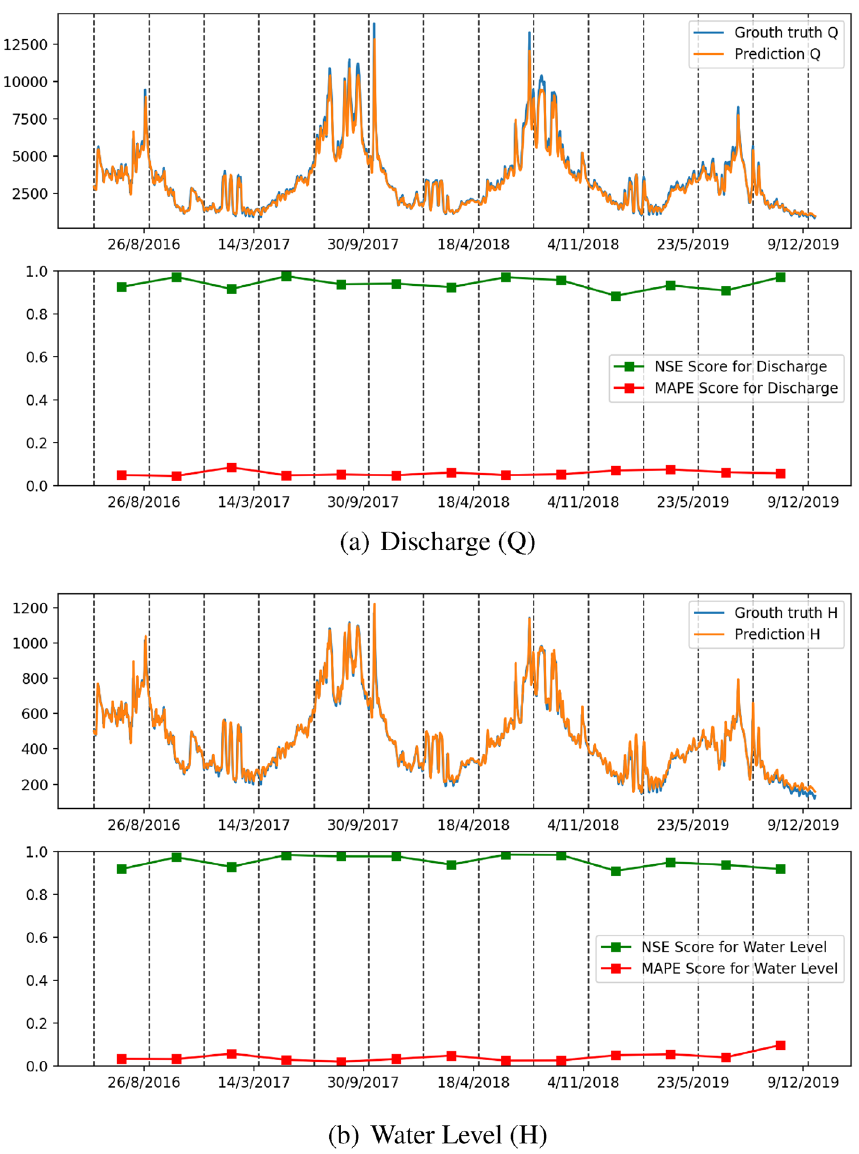
Figure 18. The model performance toward different time segments.